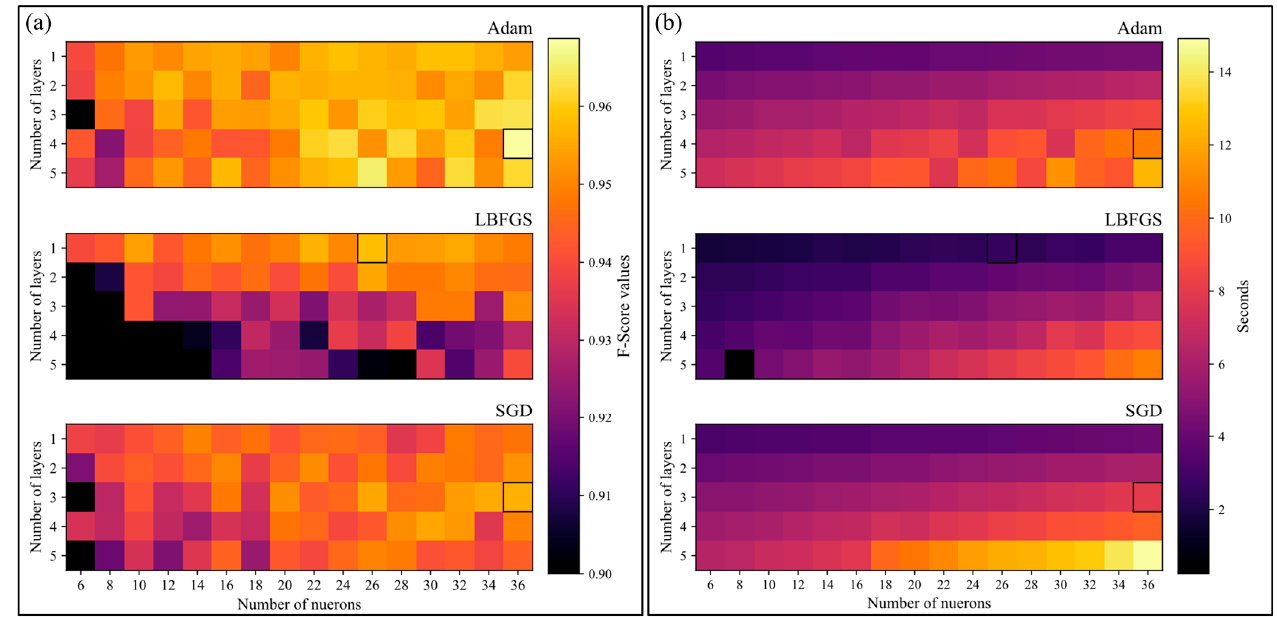
Figure 4. The ( a ) F ‐ score values and ( b ) computation times of the grid search of the artificial neural networks (ANNs) algorithm with different topologies (i.e., number of layers and neurons) and three learning algorithms of adaptive moment estimation (Adam), limited memory Broyden–Fletcher– Goldfarb–Shanno (LBFGS), and stochastic gradient descent (SGD). The black square determines the best ANN topology for each learning algorithm.